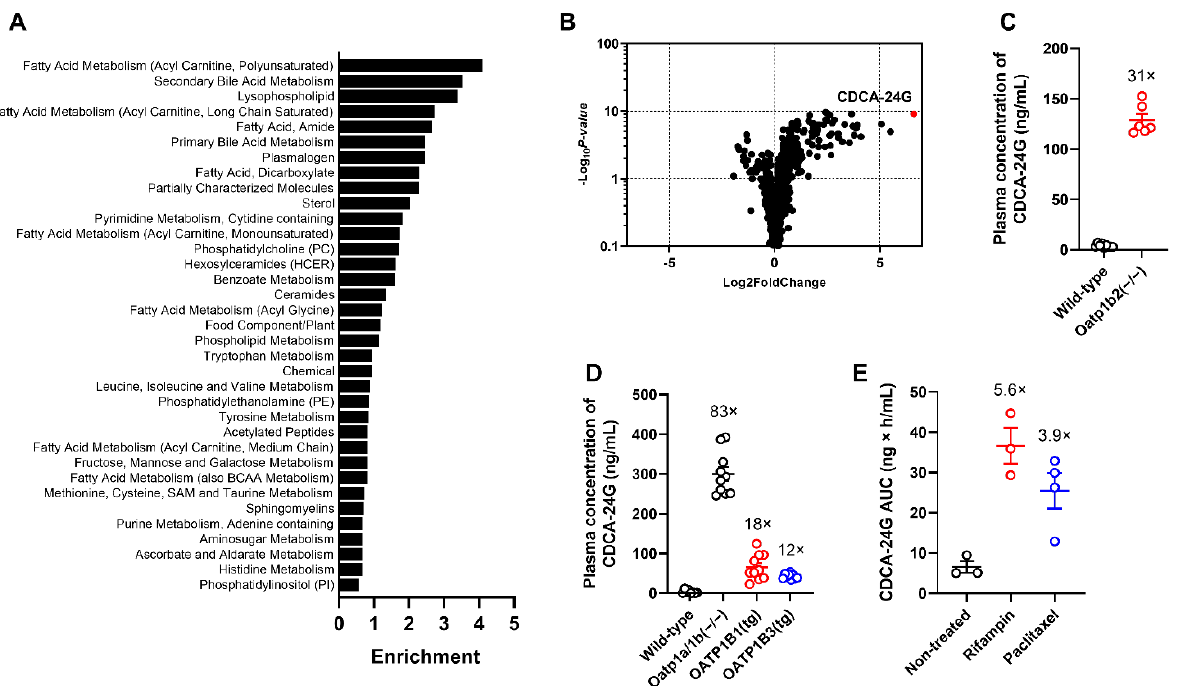
Figure 2. Identification of endogenous biomarkers of OATP1B-type transporters. ( A ) Enrichment of bile acid metabolic pathways, based on differential metabolite profiles, using plasma samples from untreated wild-type mice or Oatp1b2( − / − ) mice. ( B ) Differentially circulating levels of endogenous metabolites in plasma of wild-type mice or Oatp1b2( − / − ) mice. Positive fold change indicates higher plasma concentration in Oatp1b2( − / − ) mice ( n = 6 per group). ( C ) Validation of altered plasma levels of CDCA-24G in wild-type mice or Oatp1b2( − / − ) mice ( n = 6 per group). ( D ) Differential plasma levels of CDCA-24G in wild-type mice, Oatp1a/1b ( −/− ) mice, OATP1B1(tg) mice, and OATP1B3 (tg) mice ( n = 6 – 10 per group). ( E ) Plasma AUC of CDCA-24G in wild-type mice receiving rifampin (20 mg/kg, i.v.) or paclitaxel (10 mg/kg, i.v.), ( n = 3 – 4 per group). All data are presented as mean ± SEM.